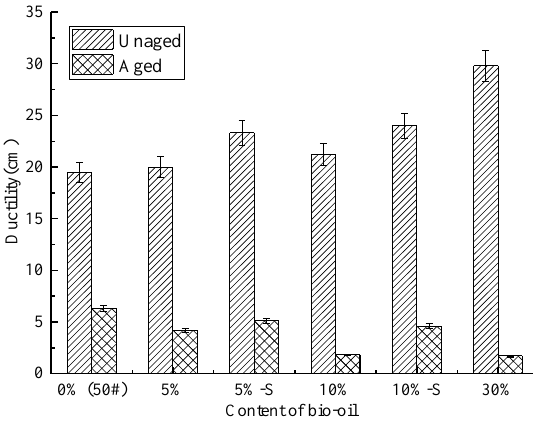
Figure 5. Ductility of unaged and RTFO aged bio-asphalt.